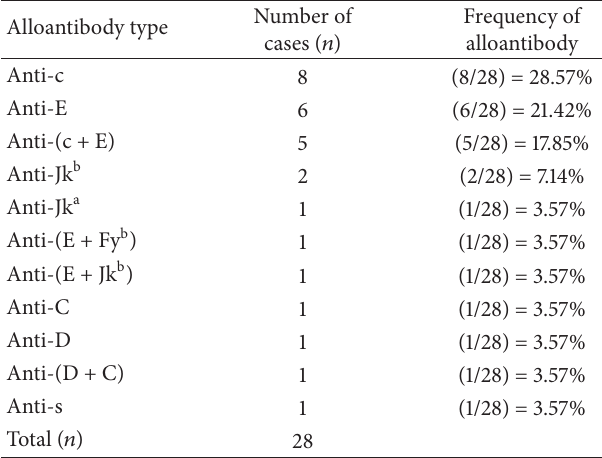
Table 2: Alloantibody